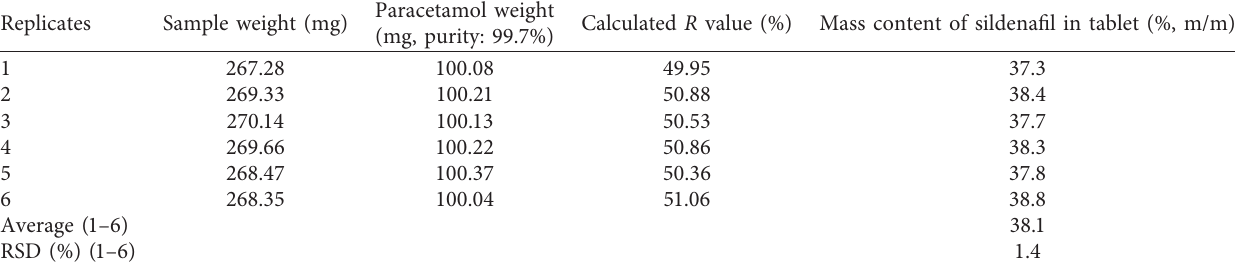
Table 4: Results of quantitation on batch